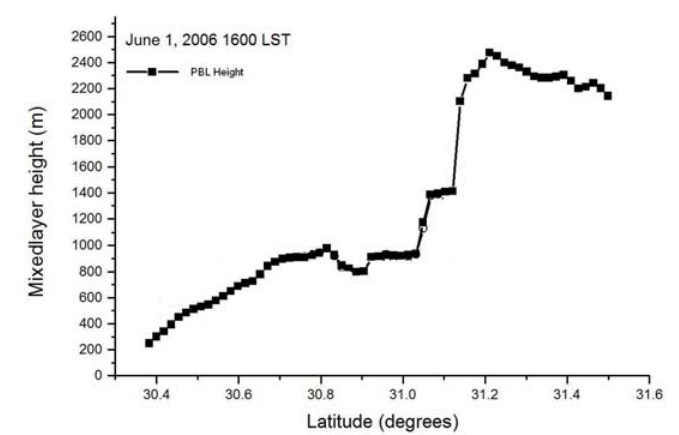
Figure 4. Simulated boundary layer height across the MS coast at 10 UTC (16 LT), June 01, 2006. The latitude of the coast is 30.4° N.